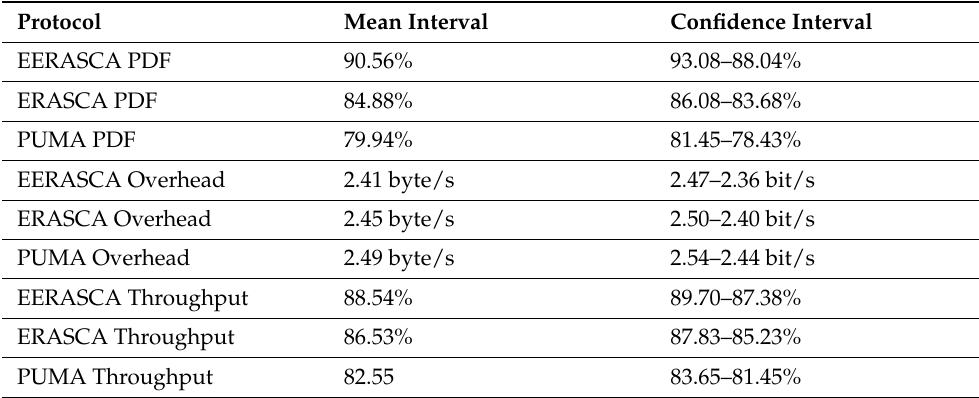
Table 4. Confidence Interval for PDF, Overhead and